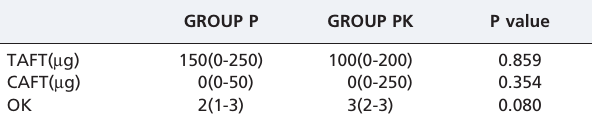
Table 6 - Fentanyl consumption for tourniquet pain (FCTP), fentanyl consumption for surgical pain (FCSP), and operative conditions (OC) (median value, minimum- maximum).